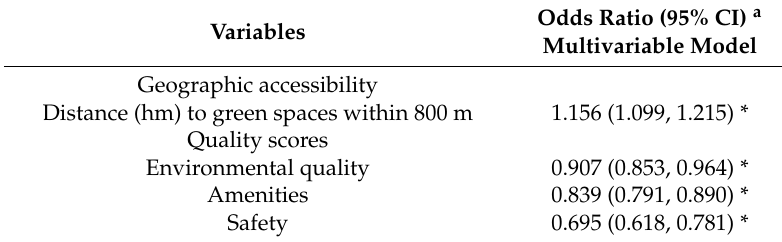
Table 5. Association between green space geographic accessibility and quality and neighbourhood deprivation